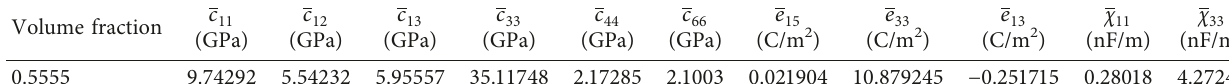
Table 2: The material properties of the singer-player PCMs strip were calculated by AHM.